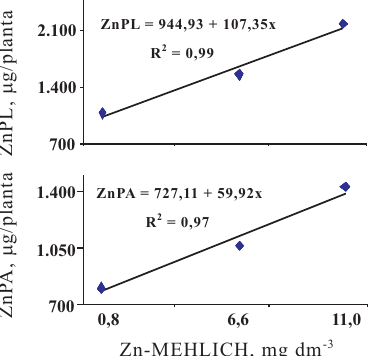
Figura 4. Conteúdo de zinco na planta inteira (Zn–PL) ou na parte aérea (Zn–PA) em função do teor disponível no solo pelo extrator Mehlich-1, na espécie C. canephora (AP).